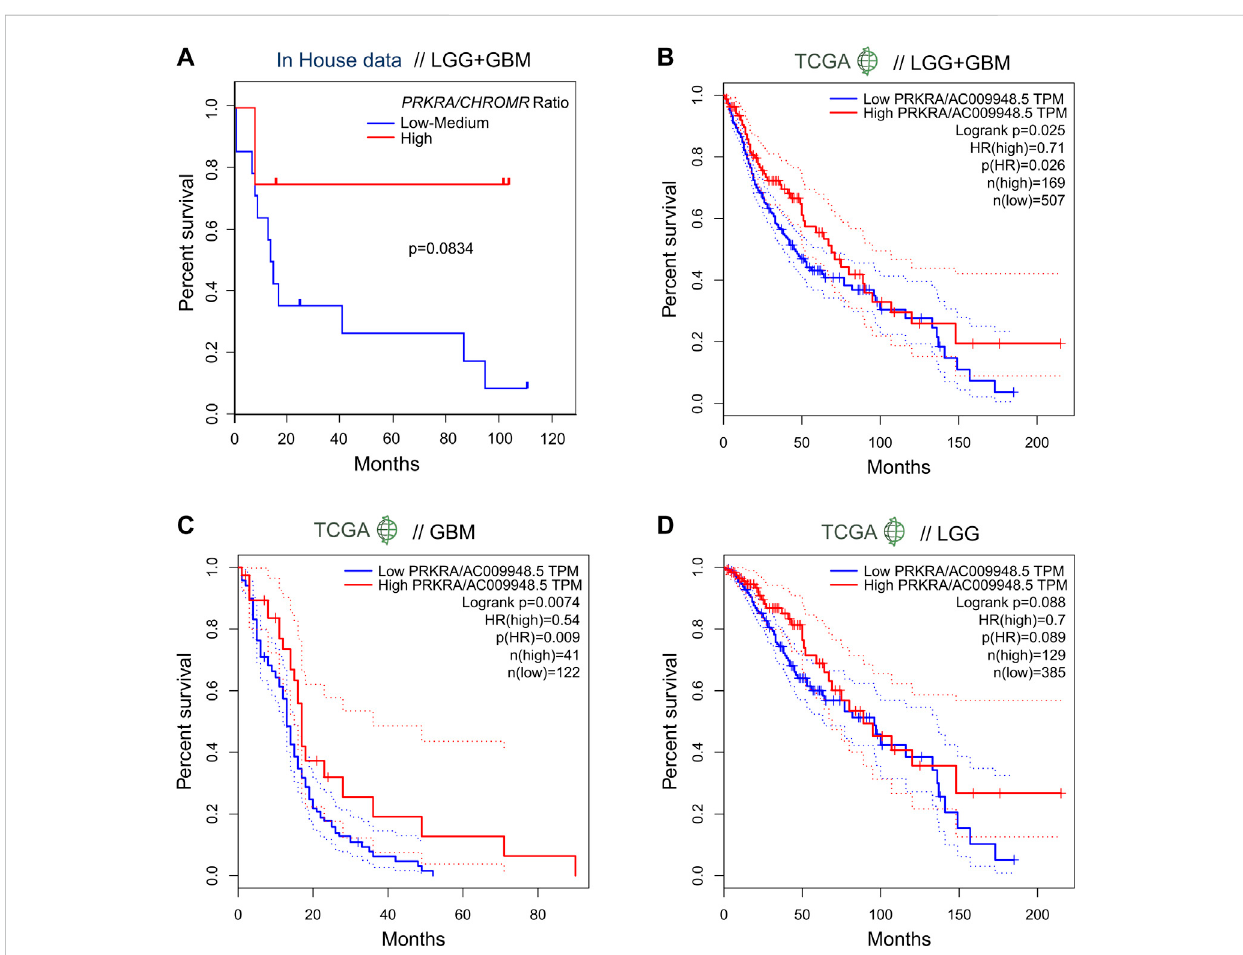
FIGURE 3 Expression ratio ofmRNAPRKRA/lncRNA CHROMR affects survivalratio ofLGGand GBMpatients. (A) Comparison ofsurvival probability forpooled LGG and GBMpatients with High mRNA PRKRA/lncRNA CHROMRexpression Ratio (above third quartile)and Low-medium expressionRatio (underthird quartile). (B – D) GEPIA tool generated patient survival curves comparing mRNA PRKRA/lncRNA CHROMR High and Low gene expression (in TPM) ratio groupsinpooledLGGandGBMdatasets (B) andseparately (C,D) ,dottedlinesindicating95%Con fi denceIntervalofthesurvivalcurve.N(TCGALGG, TCGA GBM) = 514; 163; respectively. Mantel-Cox (Log-rank) test. Statistically signi fi cant - p < 0.05. HR denotes hazard